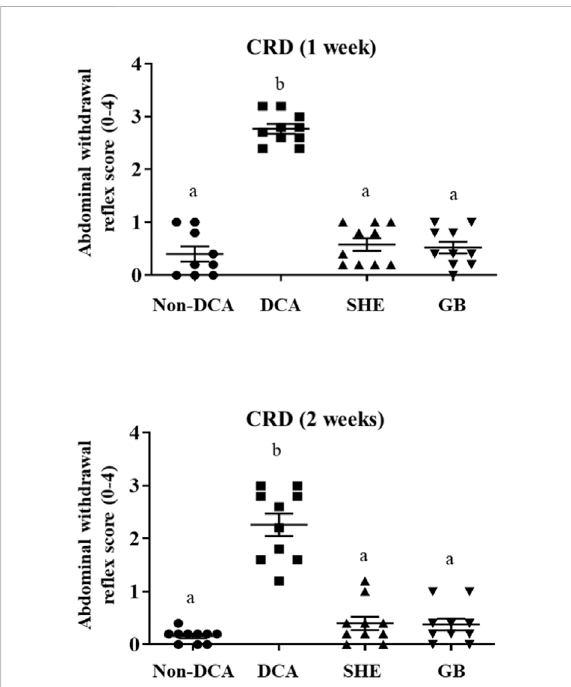
FIGURE 2 Response to colorectal distension (CRD) with a balloon catheter in fl ated to 60 mm Hg (20 s at 5 min intervals) was measured in triplicate one and 2 weeks after DCA intracolonic instillation in Serpylli herba extract (SHE) (100 mg/kg) or gabapentin (GB) (70 mg/kg) treated rats. Data are expressed as means (triplicate measurements) ± SEM ( n = 10). Groups with different letters are statistically different ( p <